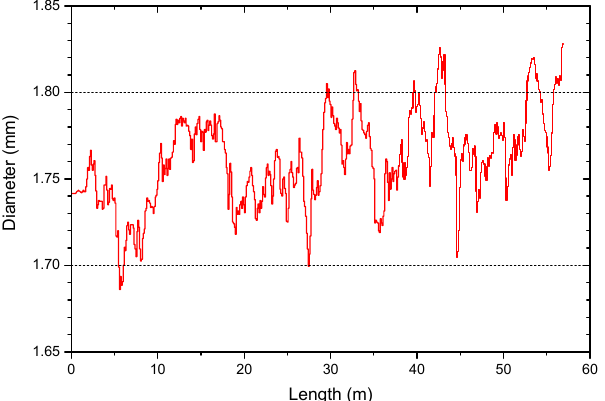
Figure 2. The diameter of the spool employed in the production of the fused filament fabrication (FFF) specimens.